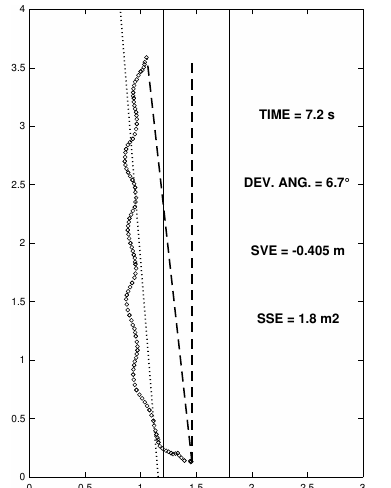
Figure 3. Participant B pre-test veering path with large deviation angle, small SSE and positive veering error path trajectory. The deviation angle is calculated as the angle comprised between these two lines and is used to express the initial orientation error. To measure the e ff ects of the errors in the step direction authors analyzed the best-fitting line by means of orthogonal linear regression. Di ff erently from the ordinary linear regression, where the goal is to minimize the sum of the squared vertical distances between the y data values and the corresponding y values on the fitted line, in orthogonal regression the goal is to minimize the orthogonal (perpendicular) distances from the data points to the fitted line. The small-pointed line (well